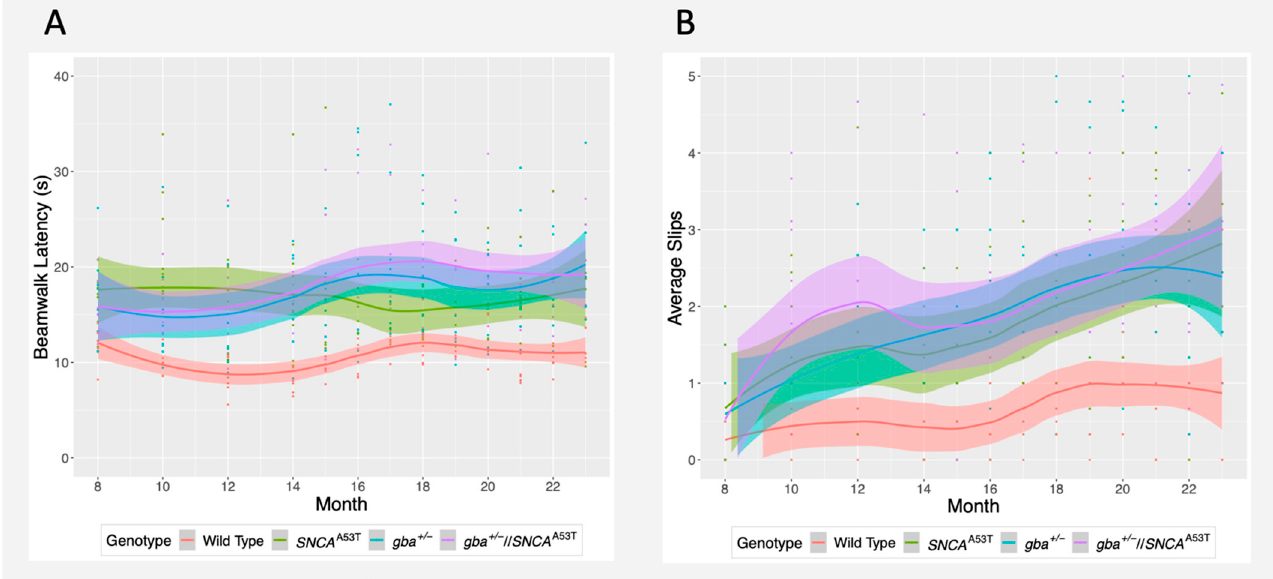
Figure 3. Beam walk latency and slip frequency over time. ( A ) Beam walk latency over time. Trend lines were calculated via LOESS regression. Colored fill represents standard error. Colored points represent measurements, coded by genotype. ( B ) Evolution of slip frequency over time, recorded between ages 8 and 23 months.